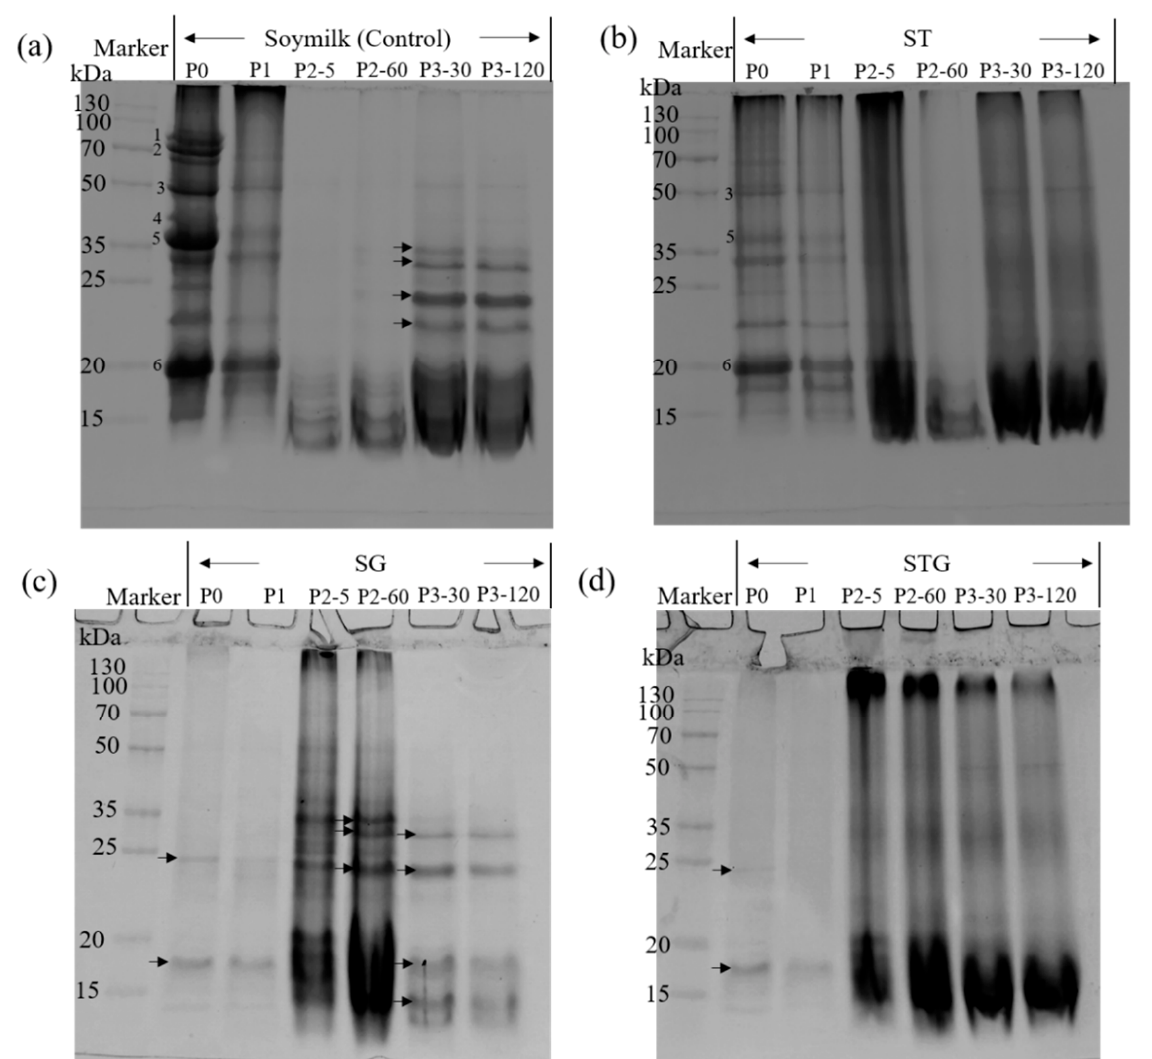
Figure 6. SDS-PAGE profiles of proteins collected from supernatant at different phases of in vitro GIS. P0 represents sample before the GIS digestion; P1 represents sample after buccal digestion; P2-5, P2-60 represent samples taken at 5 min and 60 min of gastric digestion; P3-30, P3-120 represent samples taken at 30 min and 120 min of intestinal digestion. ( a ) soymilk, ( b ) soymilk incubated with TGase (ST), ( c ) soymilk incubated with GDL (SG), ( d ) soymilk pre-treated by TGase and then coagulated by GDL (STG).